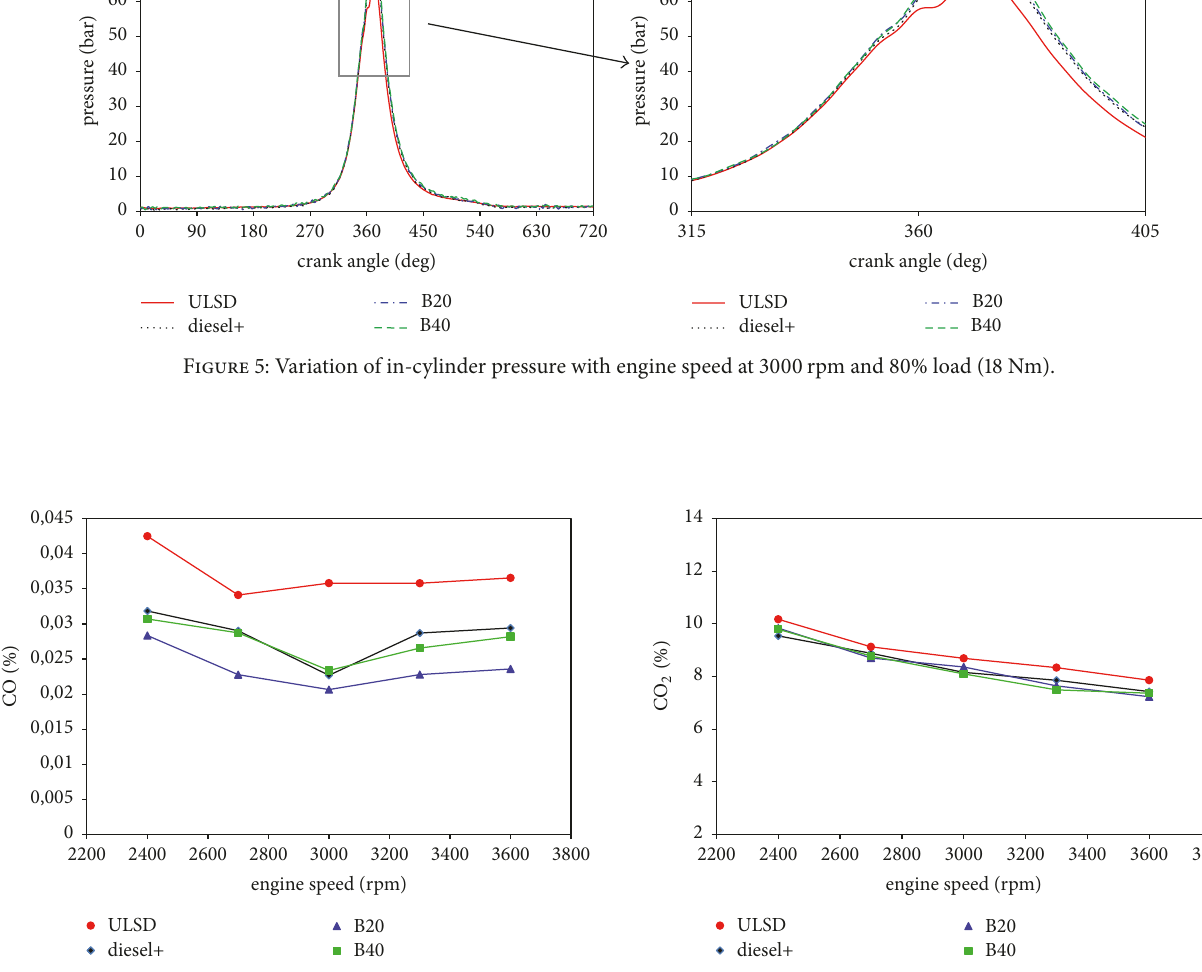
Figure 6: CO emission variation with engine speed at 80% load.